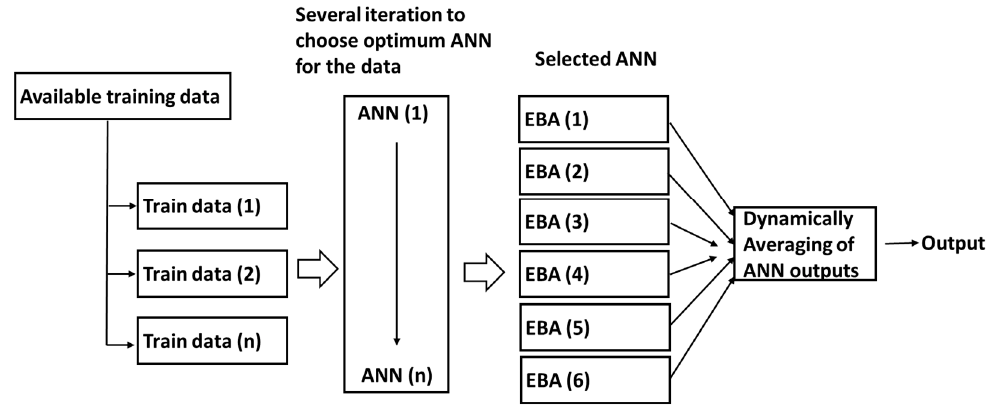
Figure 5. An EBA learning process for the EBA.